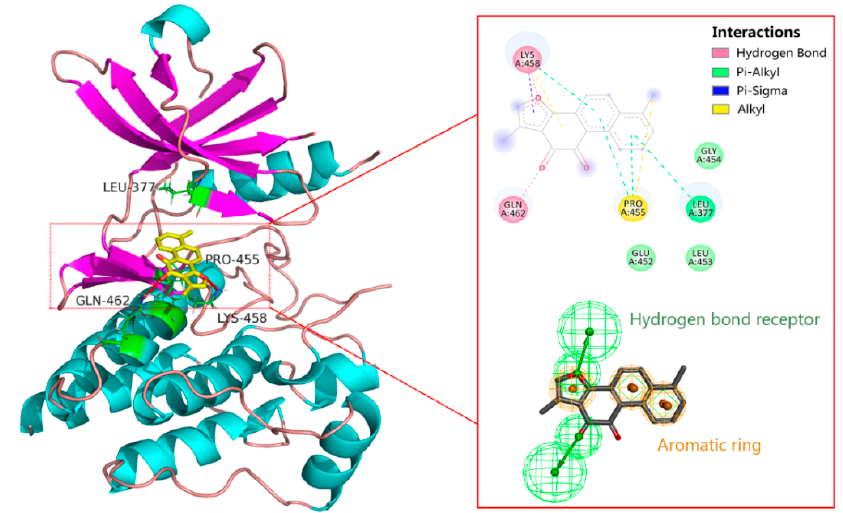
Figure 6. The binding site of tanshinone I in the inhibitor binding site of Syk.